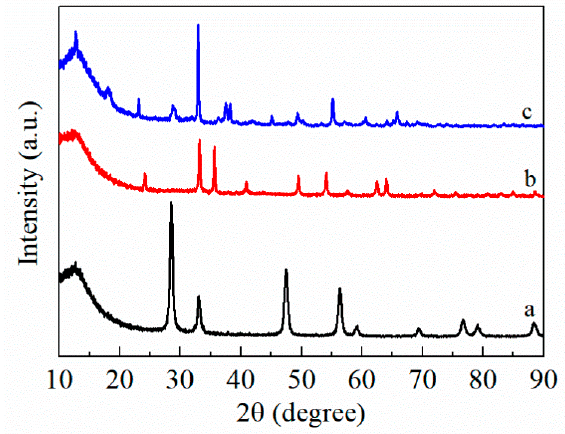
Figure 2. XRD patterns of ( a ) CeO 2 , ( b ) Fe 2 O 3 , ( c ) MnO 2 .